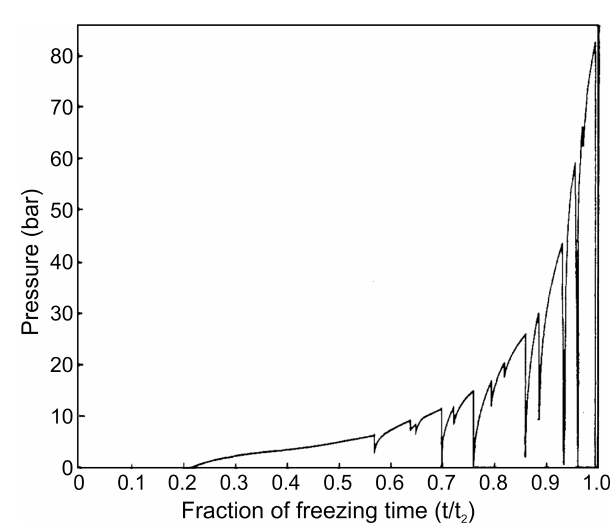
Figure 6. A time series of pressure changes inside an 11mm di- ameter drop freezing in a bath at − 5 ◦ C (adapted from King and Fletcher,